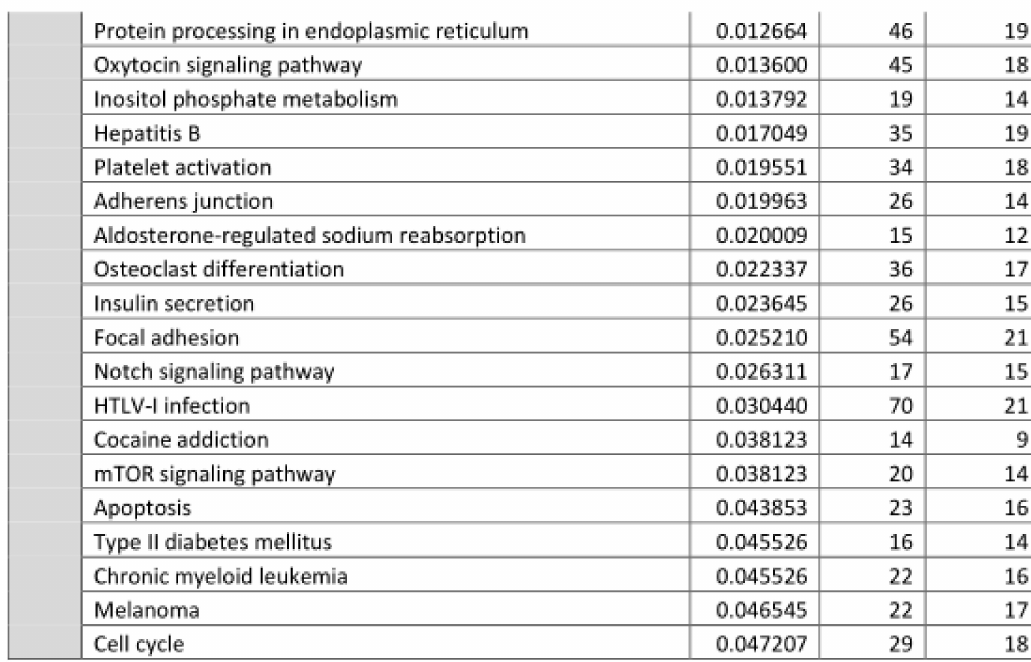
Figure A2. Full lists of the significantly enriched pathways from the functional annotation analysis of up-regulated, down-regulated, and combined DE miRNA